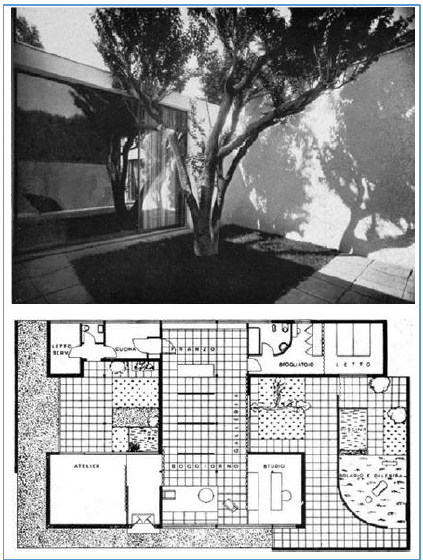
Figure 5. (Villa studio for an artist), Milan, V Triennale, 1933. Luigi Figini and Gino Pollini.